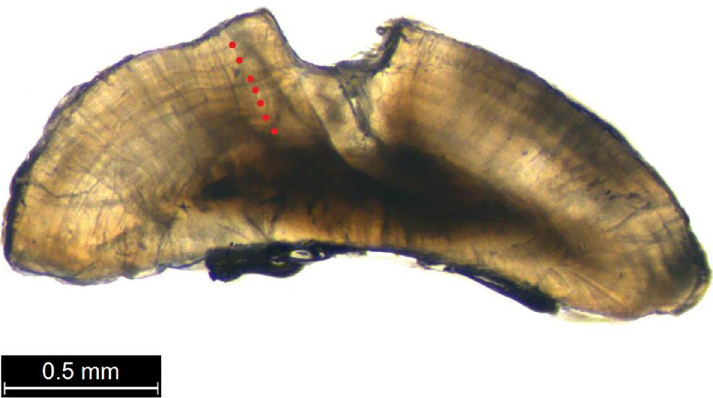
Fig 2. The left sagittal otolith of a seven-year-old A . nigrofuscus . Red dots represent the seven annuli